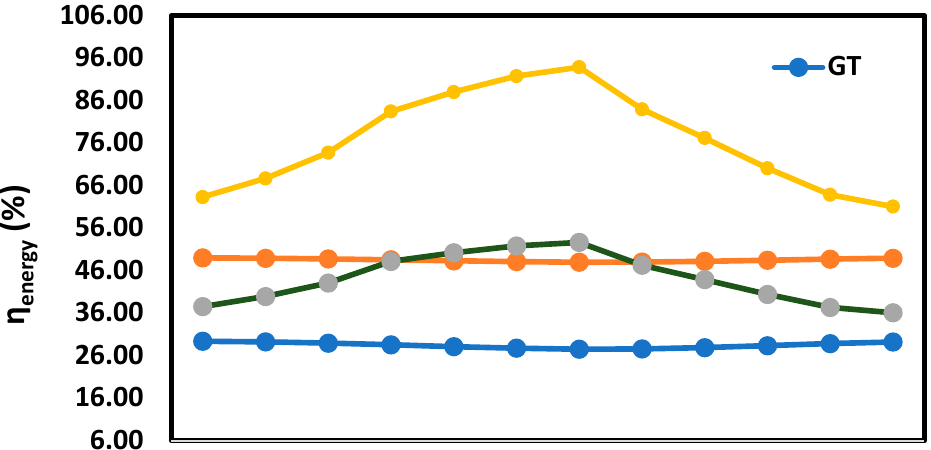
Figure 9. Monthly average of energy efficiency of four types of GT, GT + HRSG, GT + HSR, and GT + HRSG + HSR.